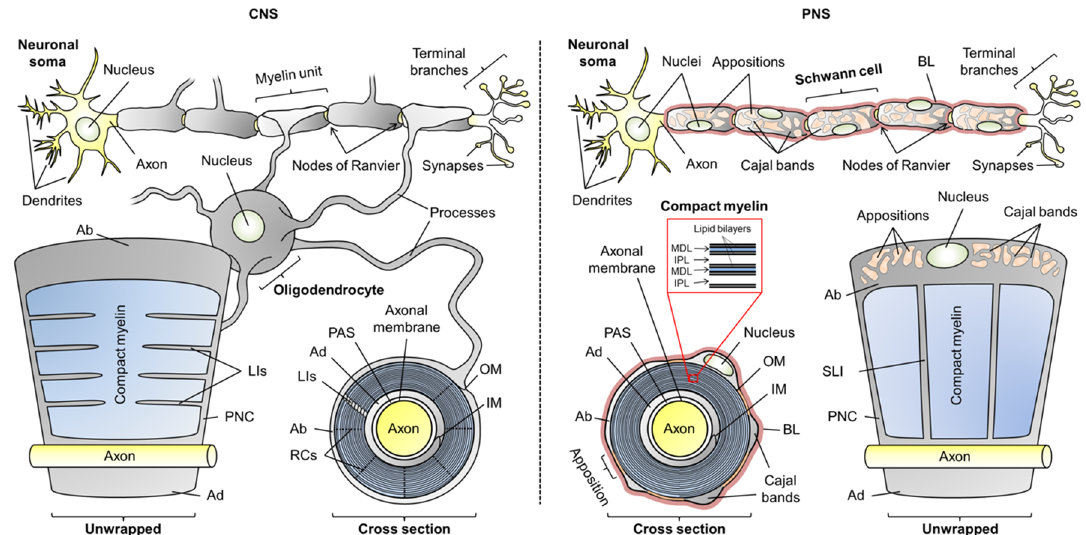
Figure 1. The anatomy of oligodendrocytic and Schwann cell myelin sheaths in the central nervous system (CNS) and peripheral nervous system (PNS), respectively. The arrangement of multiple myelin units along an axon is illustrated, as well as unwrapped myelin units and cross sections. Compact myelin and non-compact myelin are colored blue and gray, respectively. Abbreviations: Ab, abaxonal layer; Ad, adaxonal layer; BL, basal lamina; IM, inner mesaxon; IPL, intraperiod line; LIs, longitudinal incisures; MDL, major dense line; OM, outer mesaxon; PAS, periaxonal space; PNC, paranodal collar; RCs, radial components; SLI, Schmidt–Lanterman incisures.